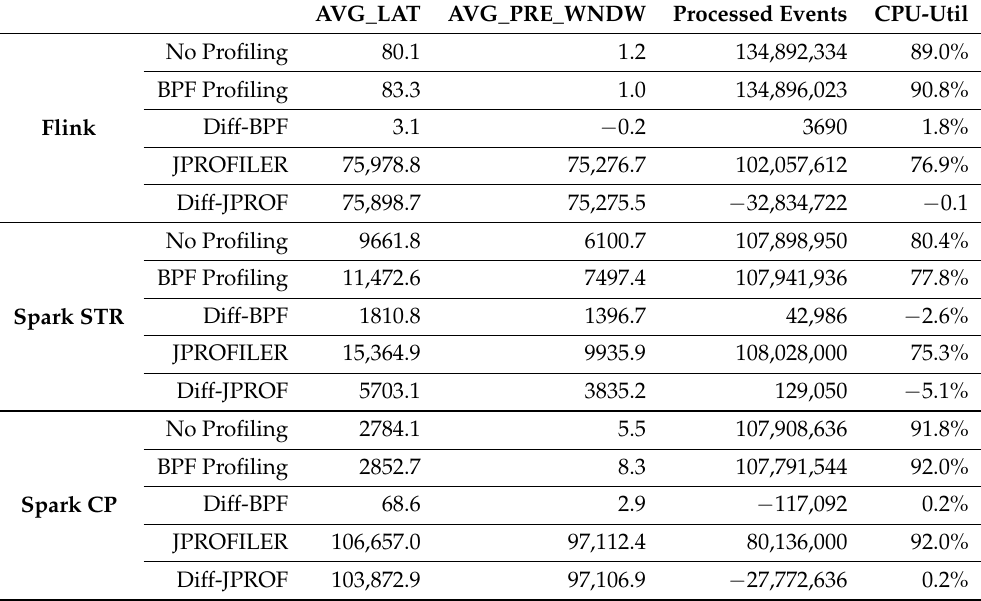
Table 1. Performance Overhead of BPF and